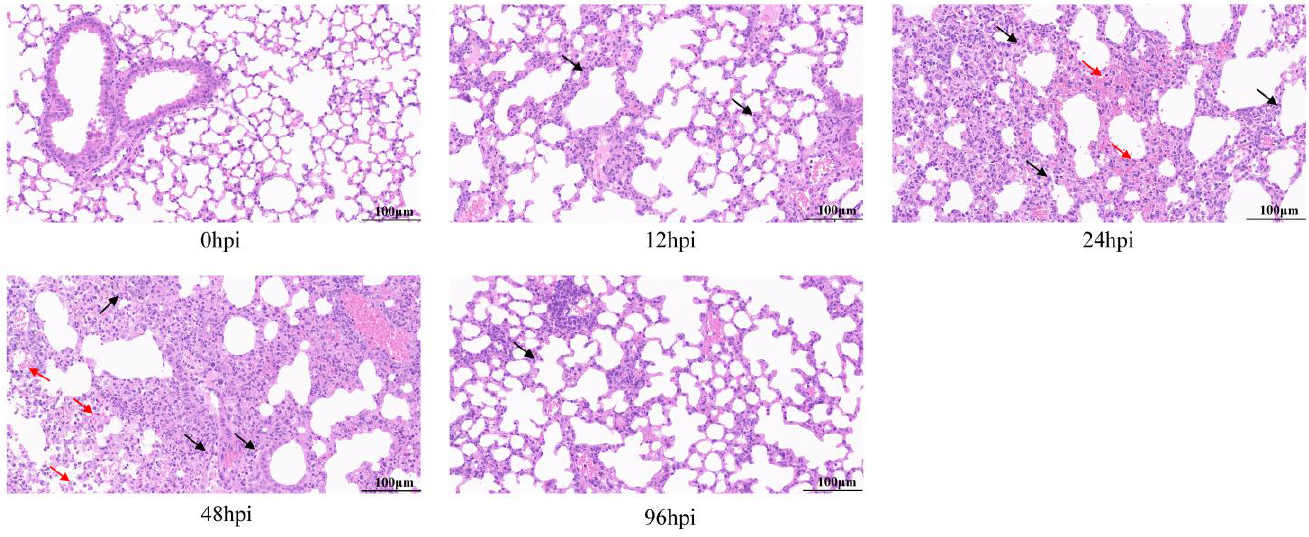
Figure 1. Pathological analysis of lung tissue infected with MRSA by hematoxylin and eosin (H&E) staining. Mice were challenged with USA300 strain (ATCC BAA-1556) of 1 × 10 8 CFU, and lung pathological changes were observed at 12, 24, 48 and 96 h after infection. Arrows show lesions: inflammatory cell infiltration is shown in black and bleeding is shown in red (original magnification = 40×; scale bar = 100 μm). hpi = hours post -infection.